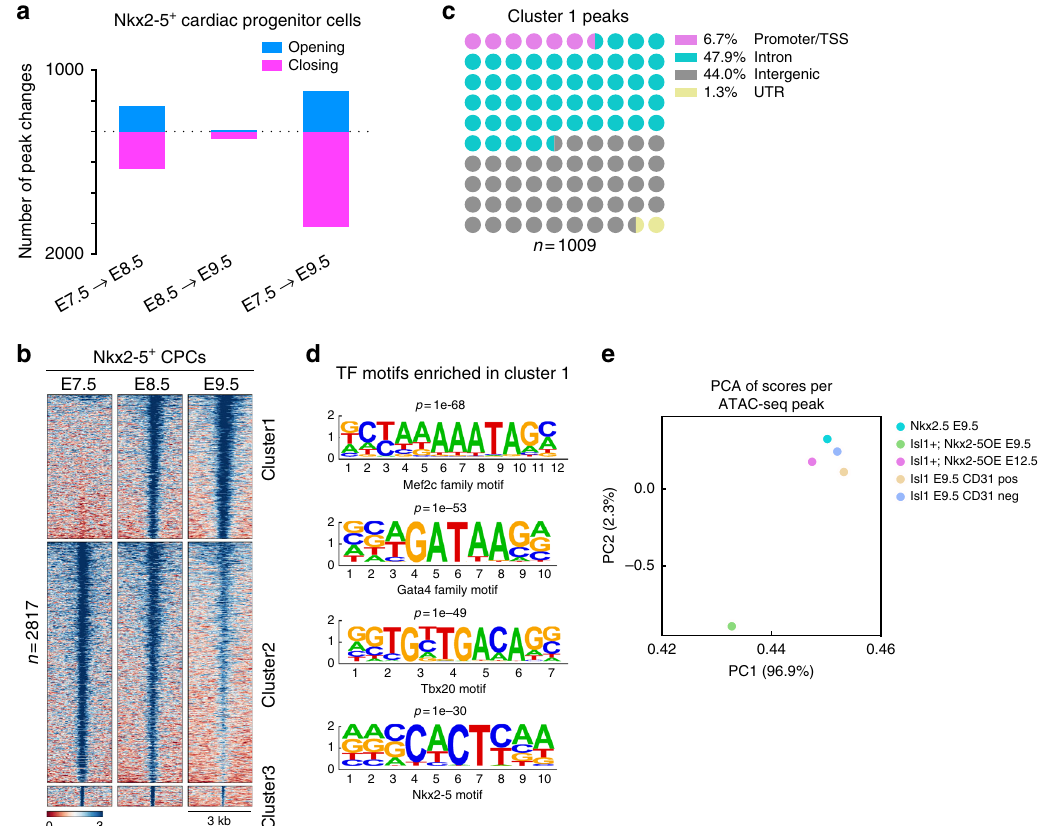
Fig. 10 Bulk ATAC-seq analysis of Nkx2-5 + CPCs. a Number of differential chromatin accessibility peaks (log2(FC) > 2, false discovery rate [FDR] < 0.05). b Genome-wide distribution of differential open chromatin peaks grouped by K -means. Each row represents one differential peak, normalized to sequencing depth, in sequential comparisons (log2[FC] > 2, FDR < 0.05). c Distribution of genomic features of differential regulatory elements. d Enrichment of known transcription factor motifs in Isl1 + /Nkx2-5OE differential peaks. The height of the letters represents the frequency of each base in the cognate motif. e Principle component analysis (PCA) showing chromatin accessibility features among indicated samples by reducing